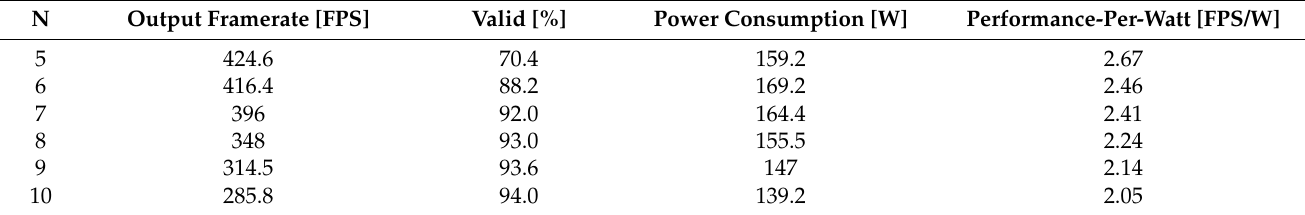
Table 4. Performance report of the GPU